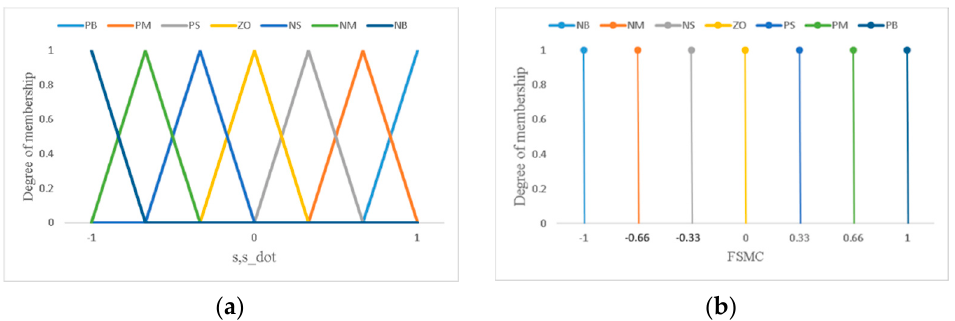
. (cid:0) (cid:1) s , s and ( b ) output